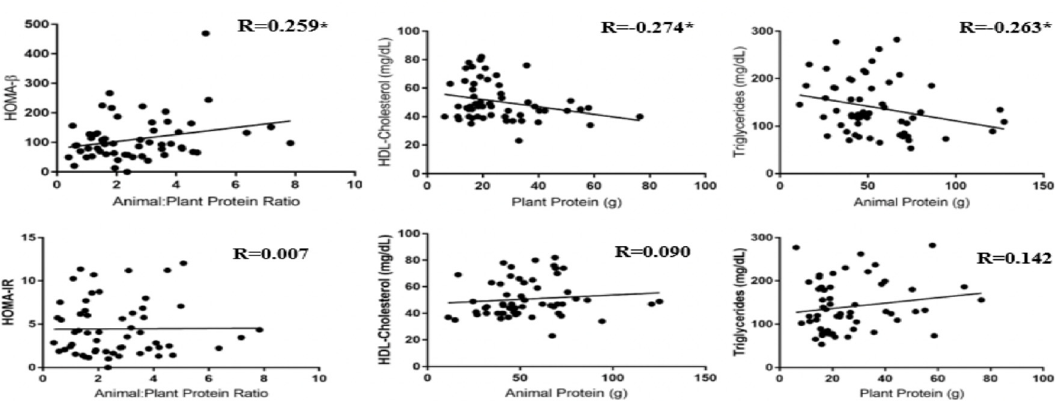
energy intake of study participants of study participants below ( n = 17), meeting ( n = 22), and above ( n = 23) the recommended protein groups (below recommended-protein group (BRP), recommended-protein group (RP), and above recommended-protein group (ARP), respectively).